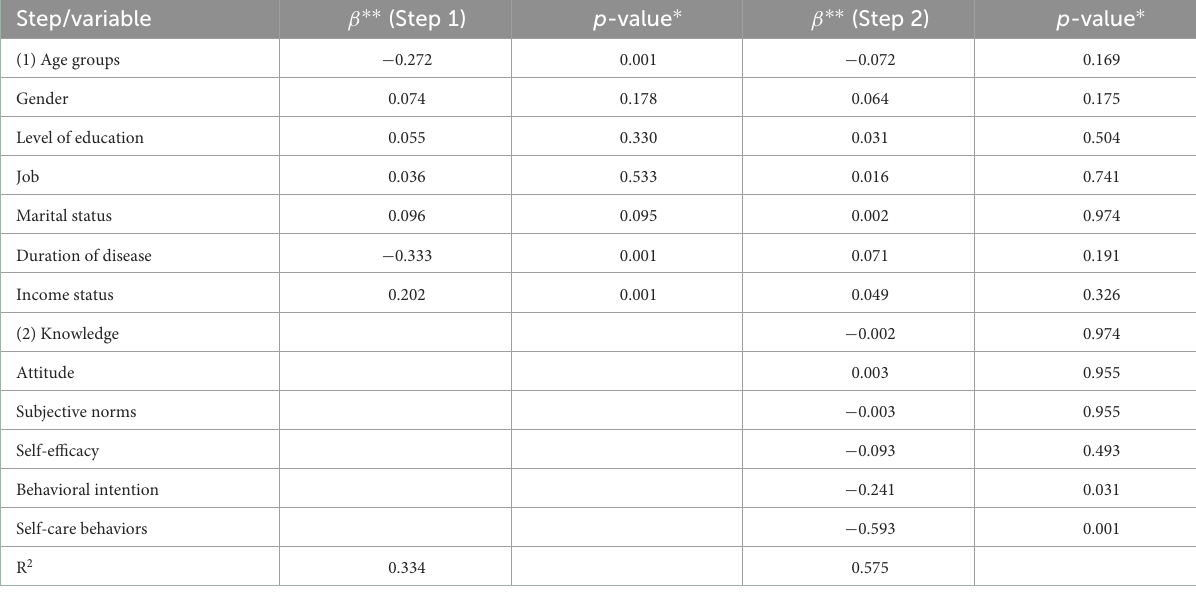
TABLE 5 Hierarchical linear regression to predict HbA1c among diabetic